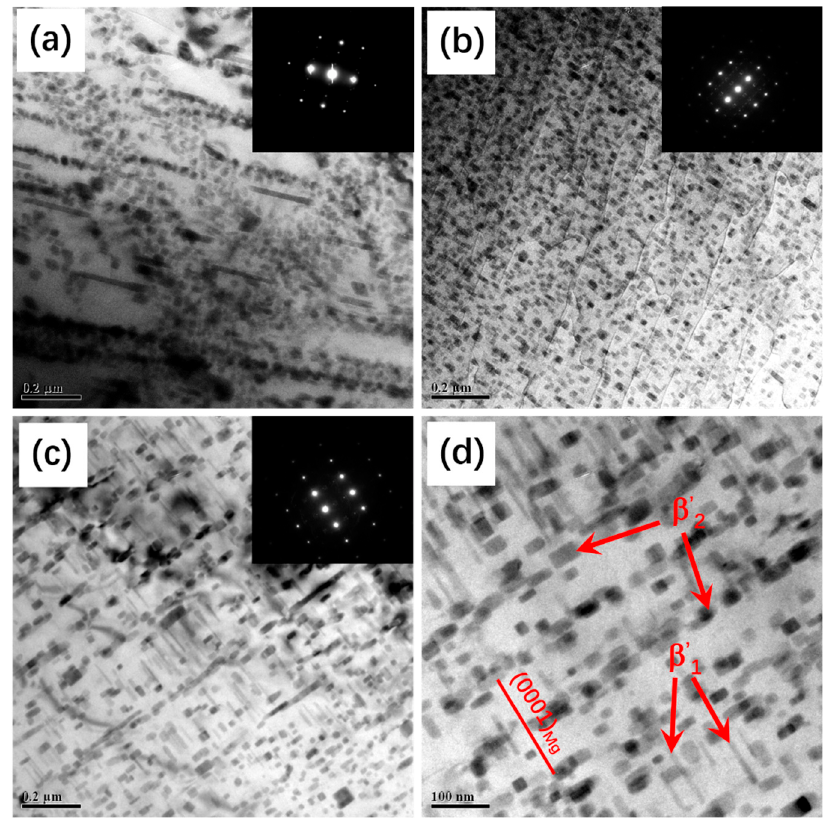
Figure 12. Bright-field TEM images of double-peak aged alloys taken from [1010] zone axis: ( a ) ZA64, ( b ) ZAT641, ( c ) low, and ( d ) high magnification of ZAT642. Metals 2019 , 9 , x FOR PEER REVIEW 10 of 14